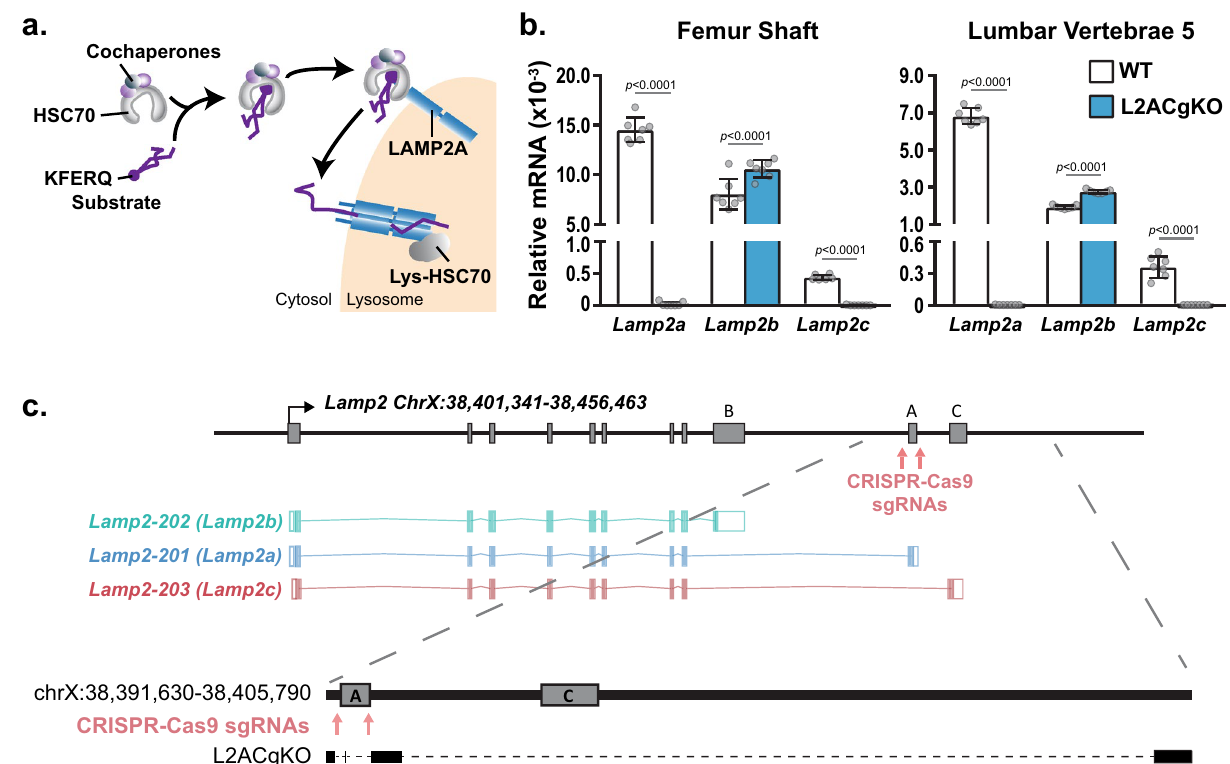
Figure 1. Production of LAMP2AC global knockout mice. (a) Illustration of chaperone-mediated autophagy (CMA). HSC70, Heat shock cognate 71 kDa protein; Lys-HSC70, lysosomal HSC70; KFERQ, pentapeptide CMA recognition motif. ( b) Femur shafts and lumbar vertebra 5 were isolated from 18-week-old male wild type (WT) and LAMP2AC global knockout (L2ACgKO) mice. mRNA levels of Lamp2 isoforms in these tissues were measured by quantitative real-time PCR (qRT-PCR) and normalized to β-actin. Bars indicate mean ± standard deviation (STDEV), n = 7 mice per genotype. mRNA values of each isoform from WT and L2ACgKO groups were compared by Welch’s t -test. c , Illustration of Chromosome X (Chr X): 38,401,341 -38,456,463 containing the Lamp2 gene. Schematic of spliced mRNAs encoding the three Lamp2 isoforms as designated by Ensembl genome browser (Lamp2 ENSMUSG00000016534, https:// useast. ensem bl. org/ Mus_ muscu lus/ Gene/ Summa ry? db= core;g= ENSMU SG000 00016 534;r= X: 37490 234- 37545 331). Red arrows indicate the locations that the CRISPR-Cas9 sgRNAs target. Large dashed lines lead to the expanded view of the ChrX:38,391,630-38,405,790 region in WT mice and the sequencing result of the same region in L2ACgKO mice. Black bars represent DNA, gray boxes indicate exons, and small dashed lines indicate deleted/missing